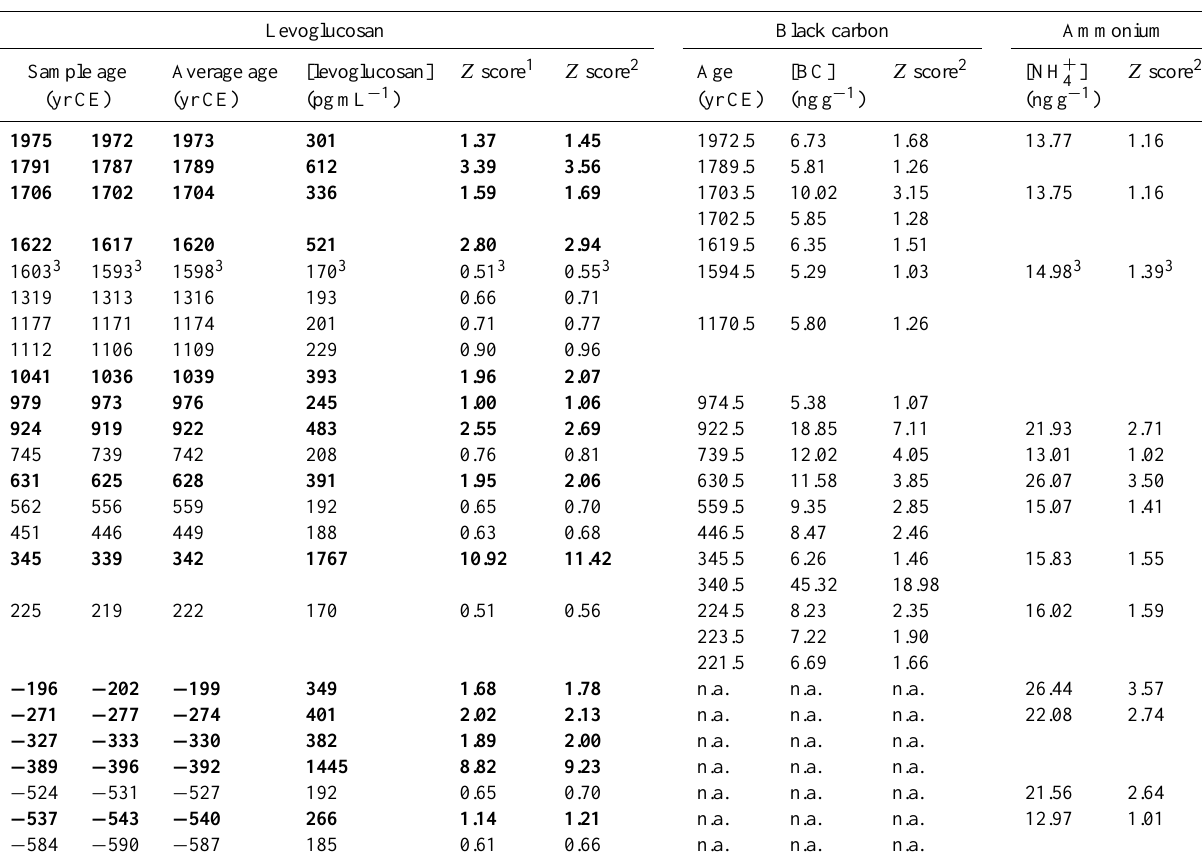
Table 1. Major levoglucosan peaks (with levoglucosan concentrations above the threshold 3rd Q + 1 . 5 IR) and their correspondence to other biomass burning proxies. Samples in bold have levoglucosan concentrations above the mean plus one standard deviation. The NH + have the same ages as the levoglucosan samples. Blank spaces demonstrate the absence of high values ( Z scores > 1); “n.a.” means that no values were